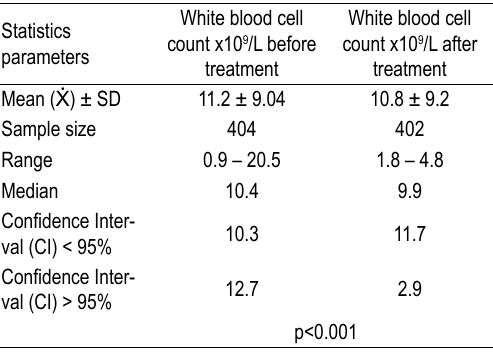
Table 8. application of concentrated red blood cells accord-